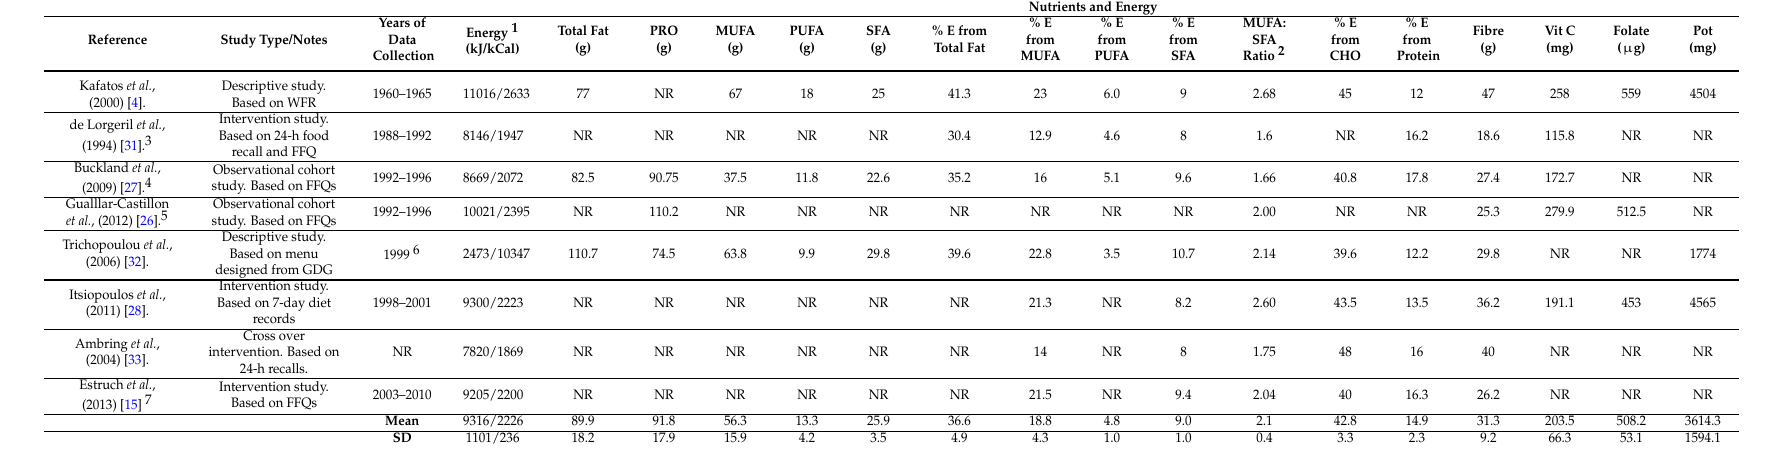
Table 4. Daily energy and nutrient content of the Mediterranean diet, in order of date of data collection, including mean ˘